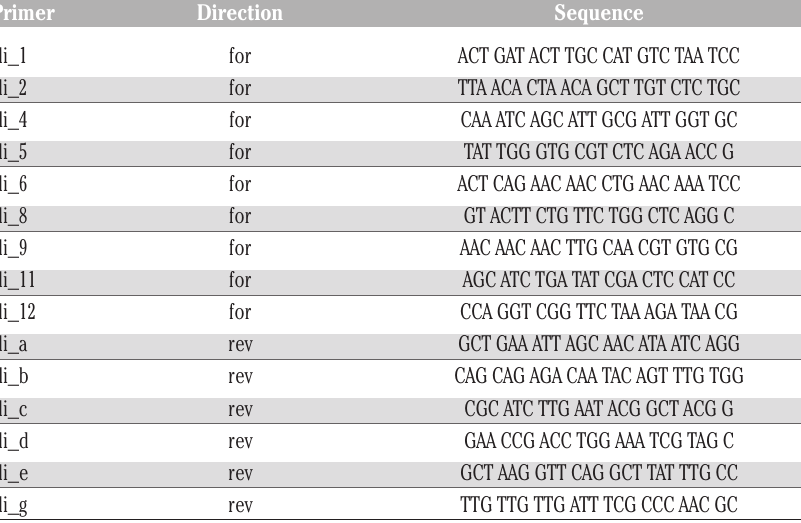
Table 2. Primers used for amplification and sequencing of flagellin genes.*